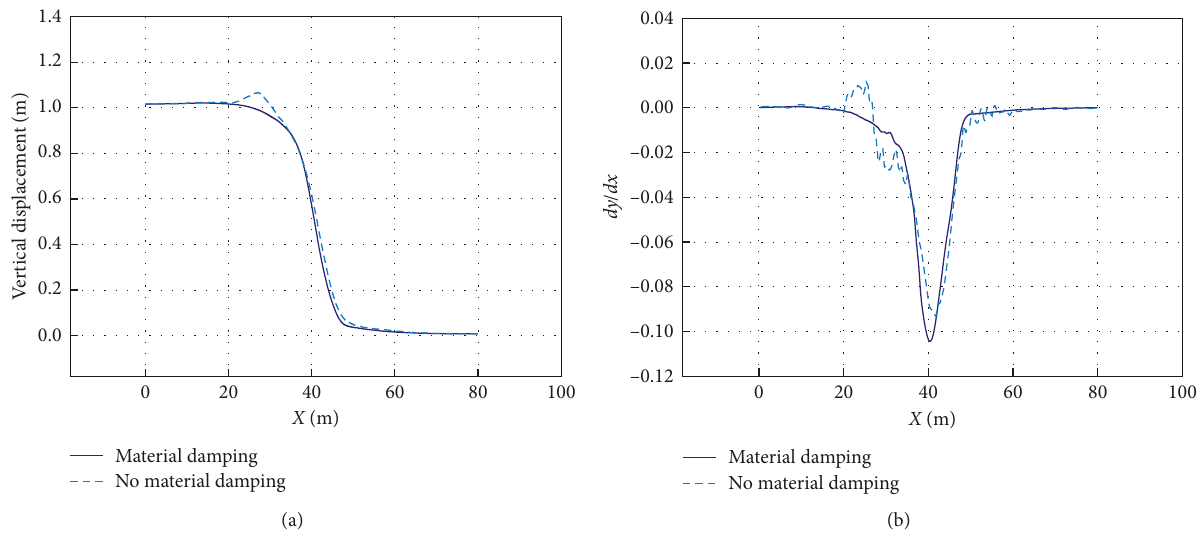
Figure 4: The displacement of the ground surface: (a) vertical displacement and (b) tilt displacement.